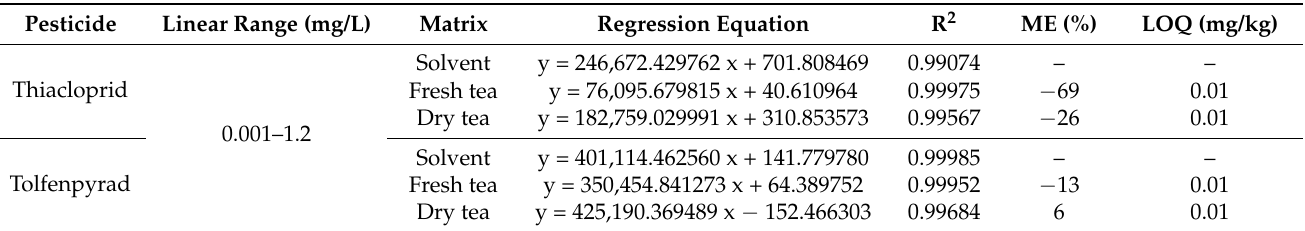
Table 1. Comparison of matrix-matched and solvent calibration of thiacloprid and tolfenpyrad.